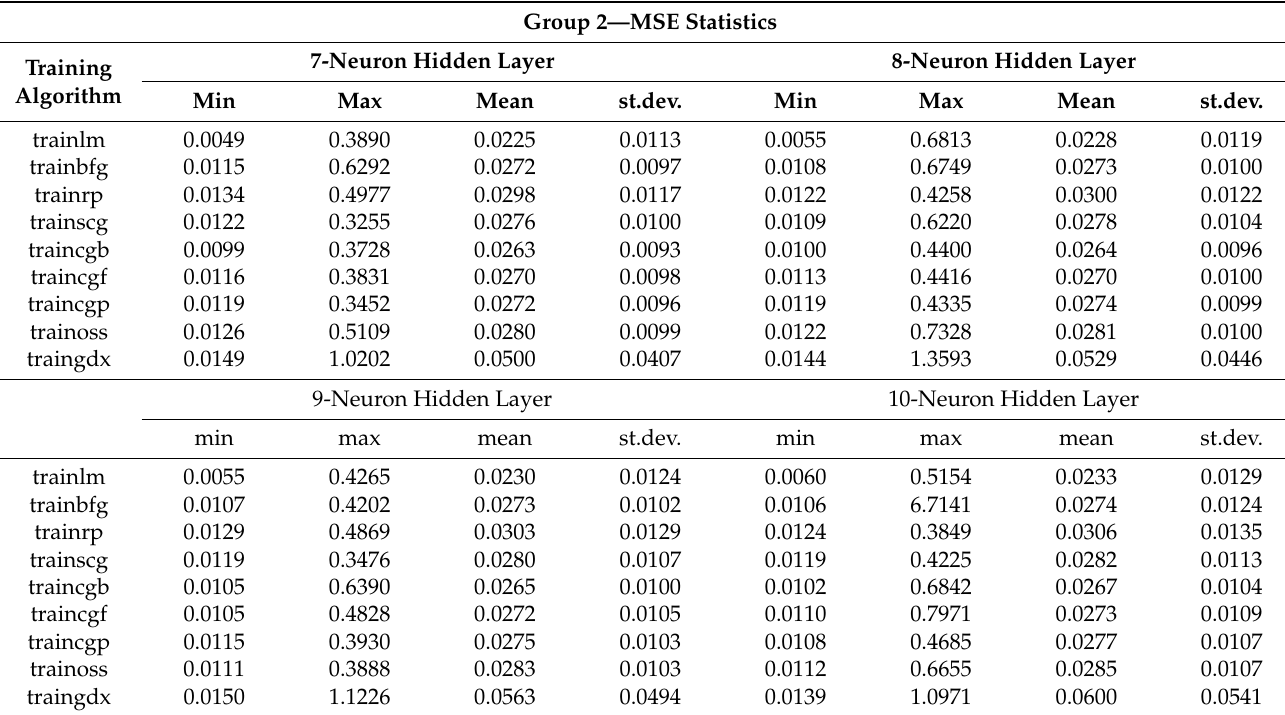
Table 7. T Statistics of MSE—ANNs with input parameters of Group 2.